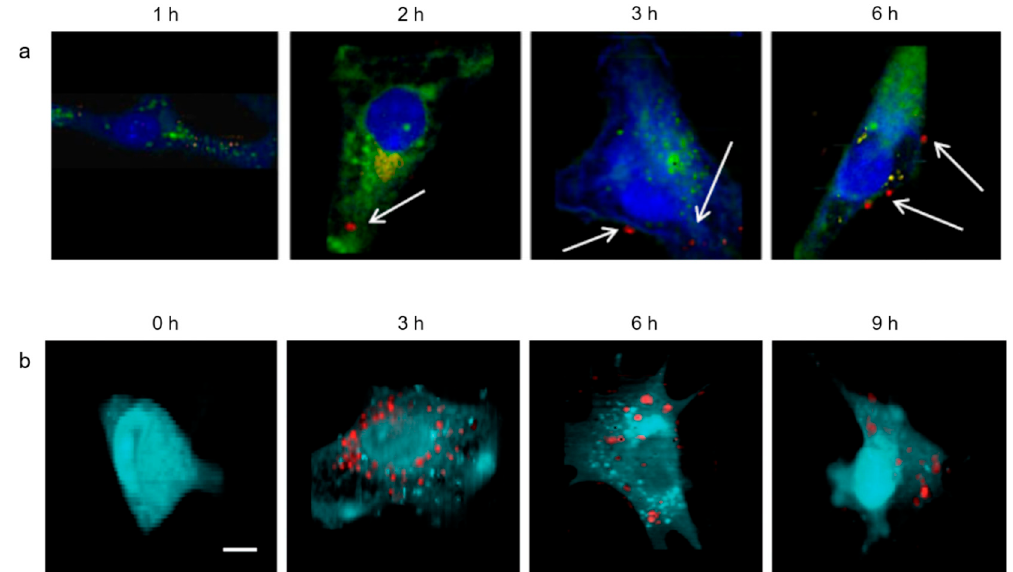
Figure 4. The uptake of polymeric nanocarriers. ( a ) The uptake of epidermal growth factor receptor targeted nanoparticles to SKOV-3 cells over time shows that particles enter after 2 h. Images are overlays of the cell body and nucleus (blue), membranous organelles (green), early endocytic vesicles (yellow), and nanoparticles (red). White arrows show regions of nanoparticle aggregation. Reproduced with permission from [82], published by Springer Nature (2013). ( b ) The uptake of β -carotene loaded poly lactic- co -glycolic acid (PLGA) nanoparticles into murine NIH-3T3 cells showing the cell body (cyan) and nanoparticles (red). Scale bar = 10 µm. Reproduced with permission from [83], Copyright John Wiley and Sons,